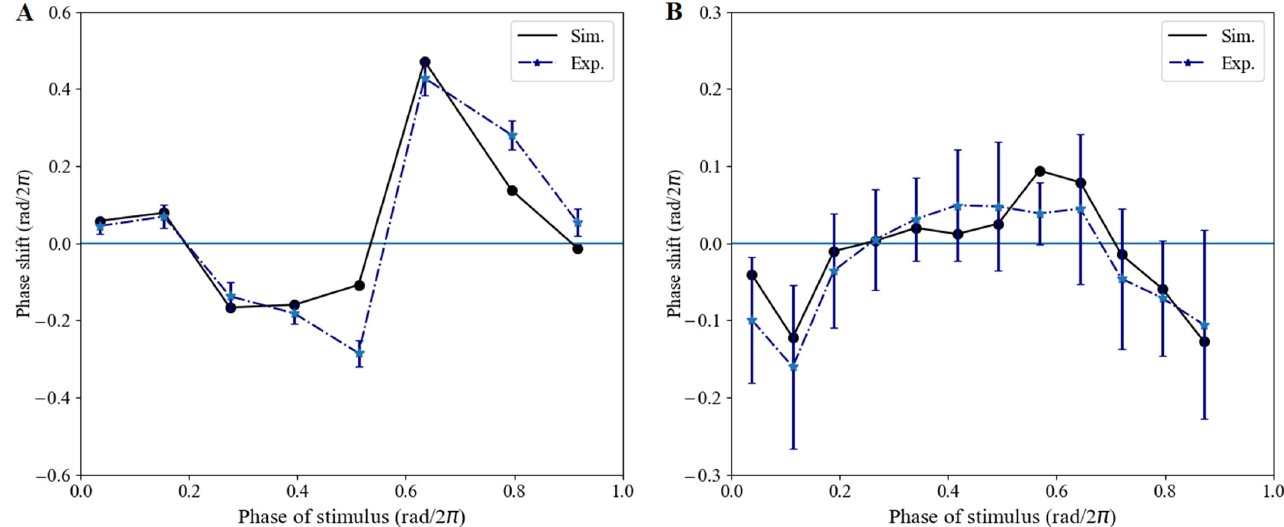
Figure 3. Phase shift validation. ( A ) WT lines were first entrained in continuous darkness; then, a red-light pulse was imposed for 1 h at an indicated time within 24 h. ( B ) WT lines were first exposed to constant red light with a 2 h dark shock at an indicated time. Black dots denote the simulated PRC (Sim.), and blue triangle and dotted line denote the experimental PRC (Exp.). Phase shift values are means ± SD in three biological replicates.